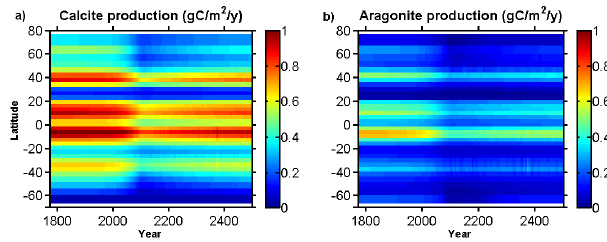
Fig. 14. Projected evolution of (a) calcite and (b) aragonite produc- tion (gCm − 2 yr − 1 ) for the CALARAG